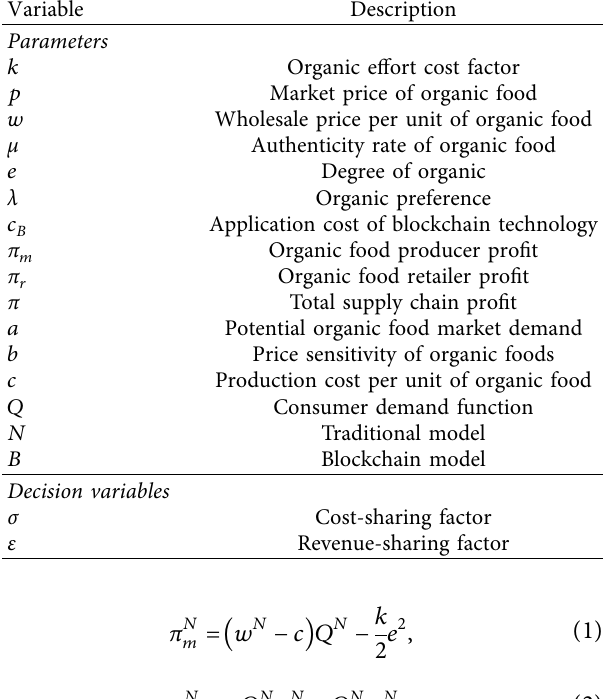
Table 2: Notation